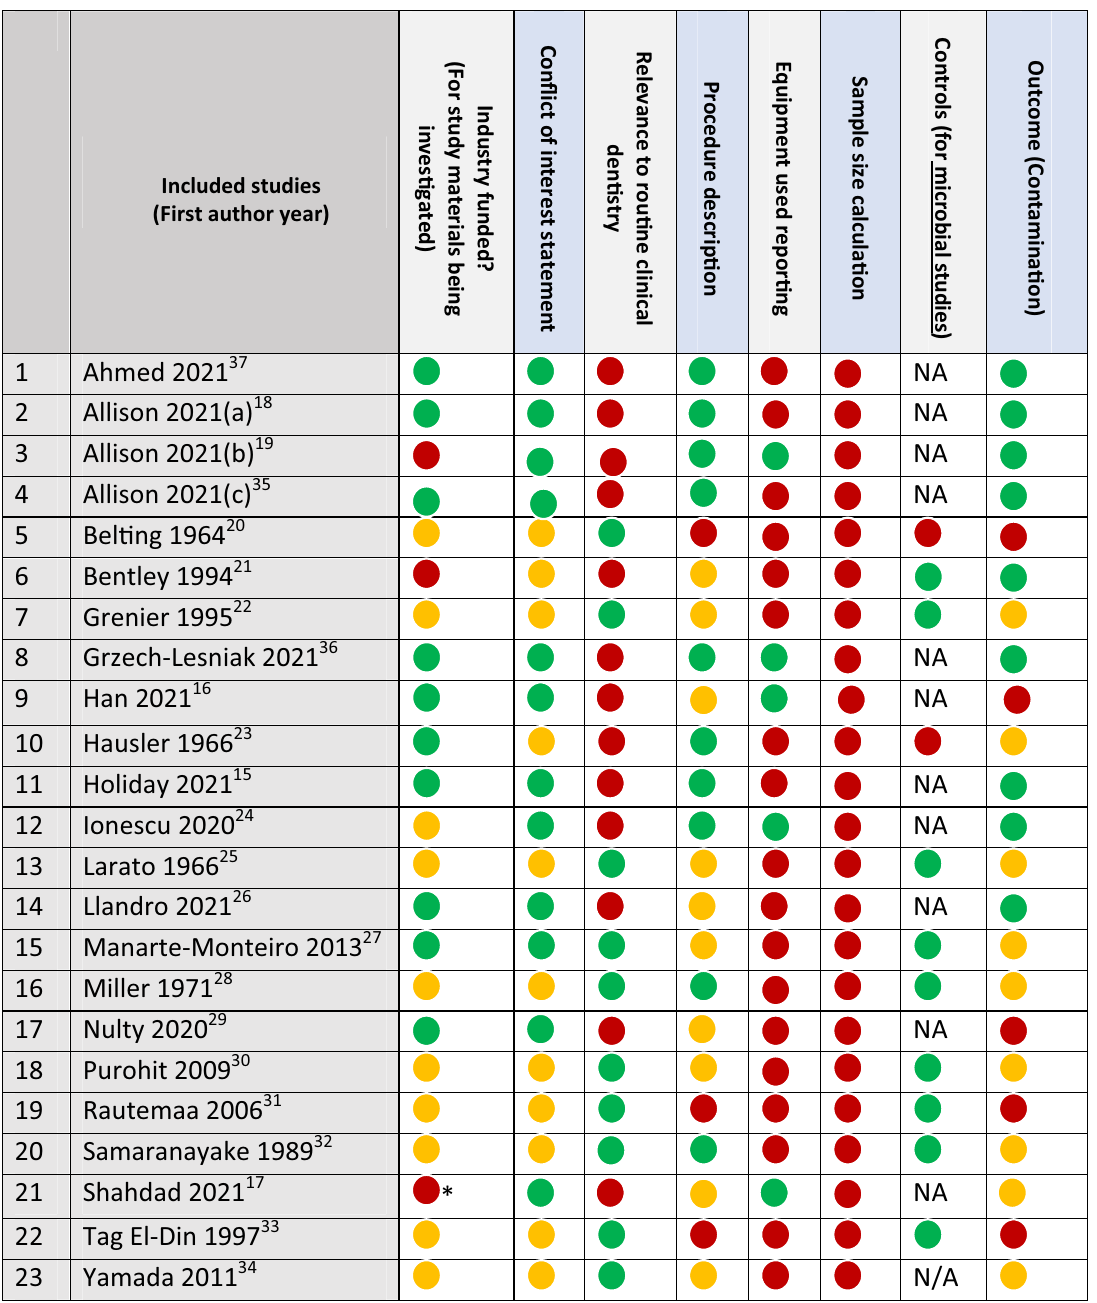
Table 8. Quality assessment of studies investigating ultrasonic scalers ( n = 23). Studies were ranked as low, moderate (amber) or high for each parameter (see protocol for full description in Appendix